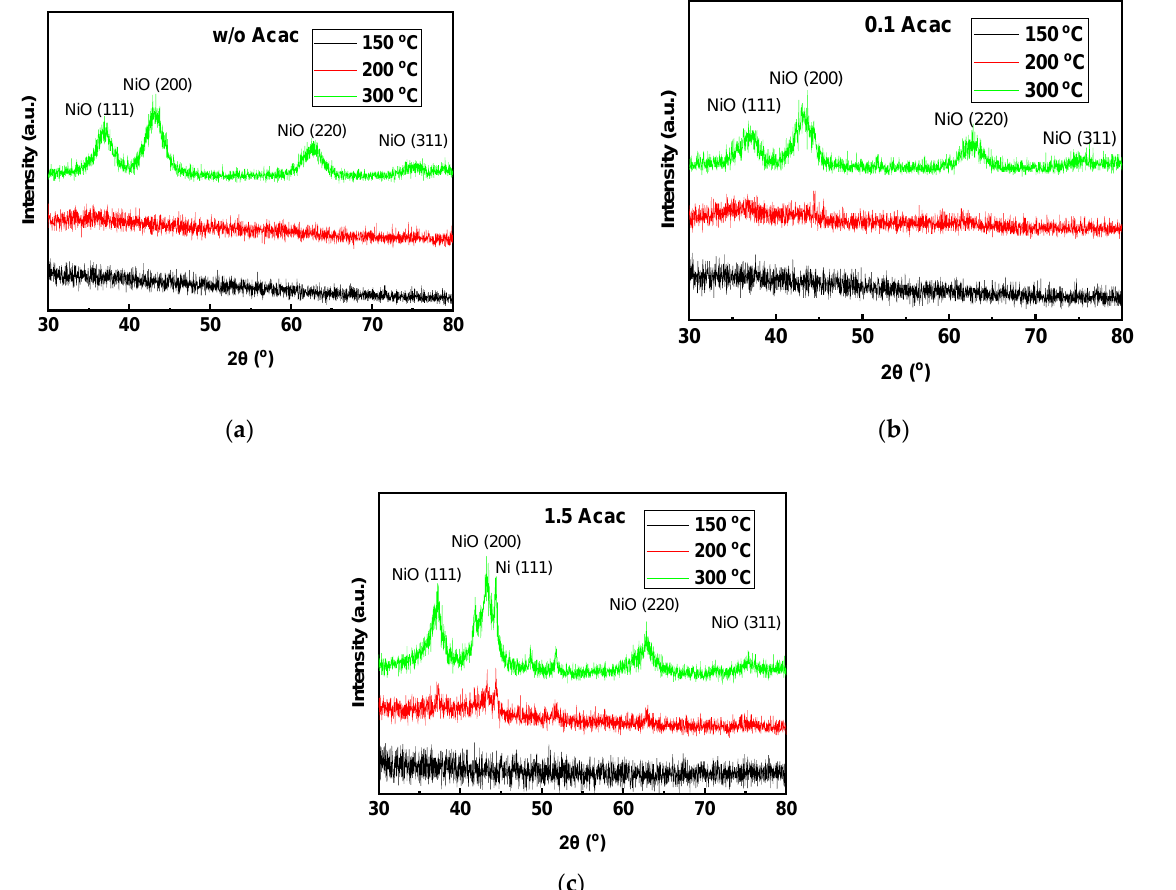
Figure 4. XRD patterns of the combustion synthesis of precursor films containing ( a ) w/o fuel (Acac), ( b ) 0.1, and ( c ) 1.5 molar ratio of fuel (Acac) to oxidizer (Cu, Ni nitrates) annealed at 150, 200, and 300 °C.